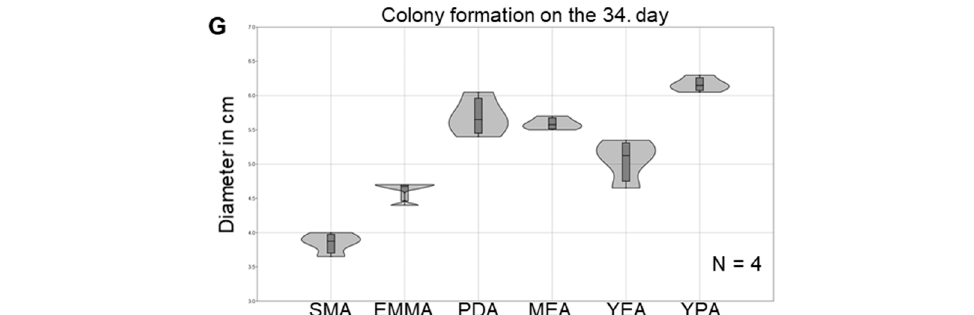
Figure 3. Morphology and growth capability of the C. olivacea strain AGSC12. ( A – F ) Colony formation of SMA, EMMA, PDA, MEA, YEA, and YPA plates in the order shown. Photos were taken after 34 days of cultivation. ( G ) Distribution of the measured diameters of the fungal colonies growing on different media at the 34th day. Violin plots show the kernel density for each sample. The box plots in the violin plots indicate the 25–75 percent quartiles. Horizontal lines within the boxes show the medians of the samples. Minimal and maximal values are depicted by the whiskers. N = sample size. Colony expansion was the most efficient on YPA plates (one-way ANOVA test, P = 2.162 × 10 − 11 ).